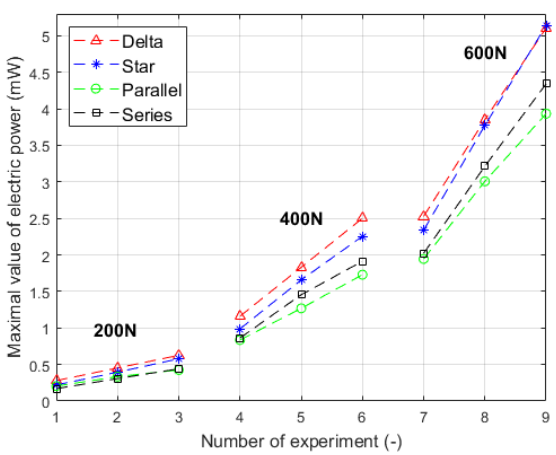
Figure 11. Comparison of maximal values of electrical power for MFC arrays. Values of optimal load resistance, for which maximal value of electric power was obtained, are presented in Table 5. Table 5. Values of optimal load resistance.